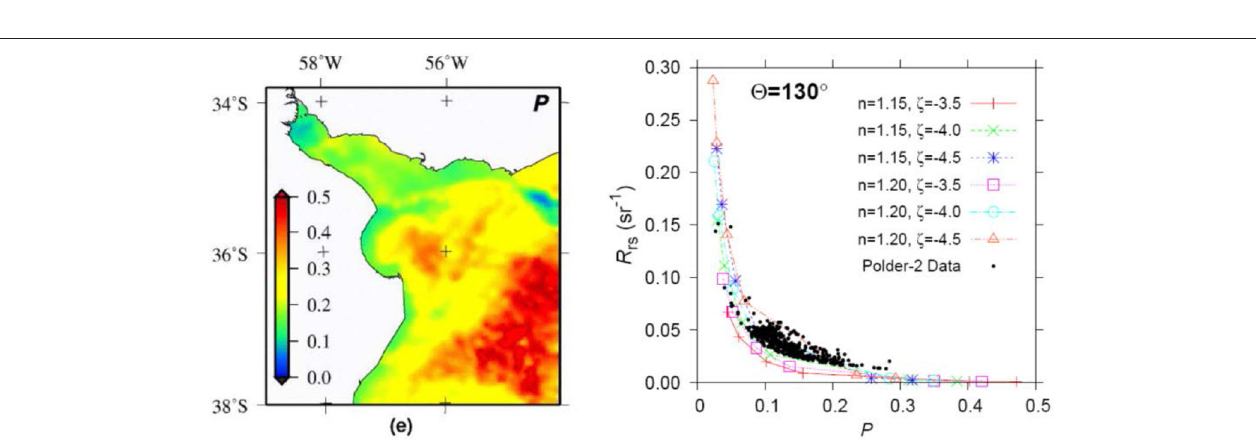
FIGURE 10 | POLDER retrieval of the DoLP shown in the left-hand side figure over complex coastal waters (Rio de la Plata estuary). The right-hand side shows the relationship, obtained from radiative transfer simulations, between the DoLP (shown as “P” on the x-axis) and the R rs for different hydrosol microphysical properties. The black dots show observed data points overlaid the theoretical relationship. Reuse with permission from Loisel et al. (2008).